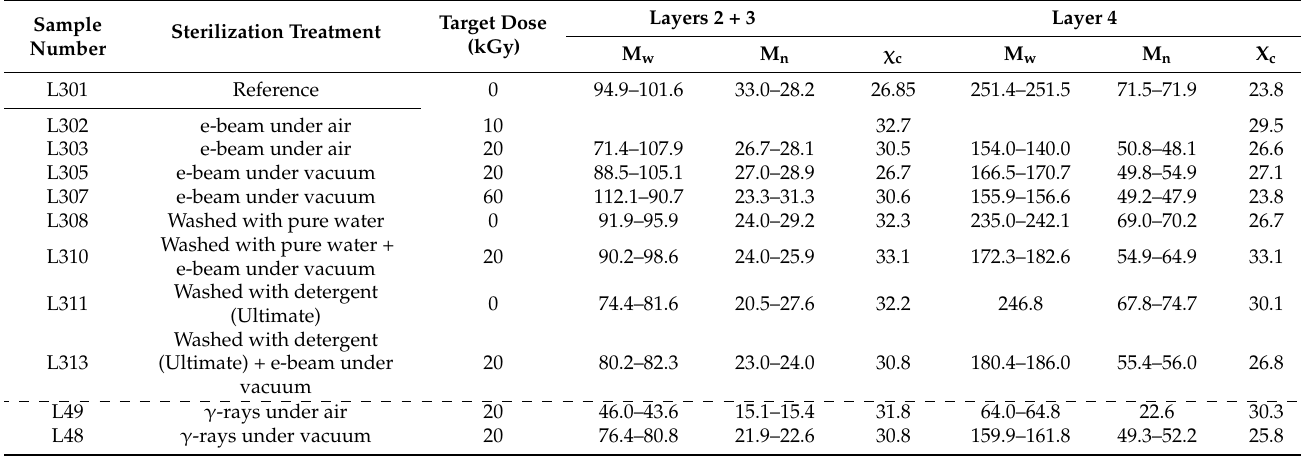
Table 3. Average molar masses (in kg mol − 1 ) and crystallinity ratios (in %) of the different layers sterilized masks for various sterilization